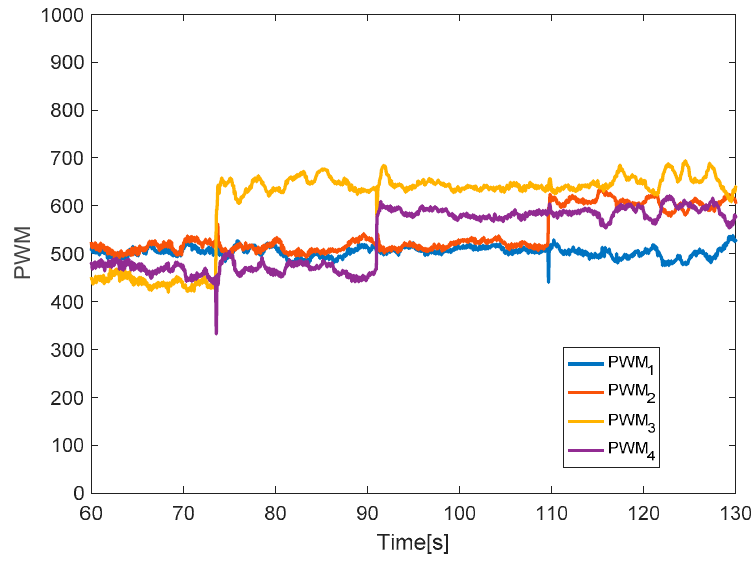
Figure 12. PWM inputs.